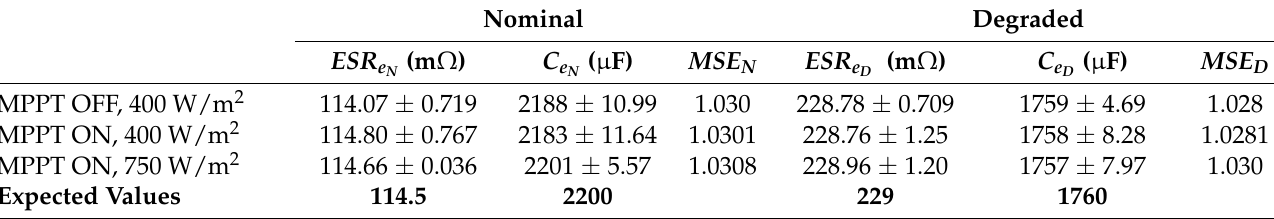
Table 3. Estimation of C and ESR indicators for non-degraded and degraded capacitor cases.